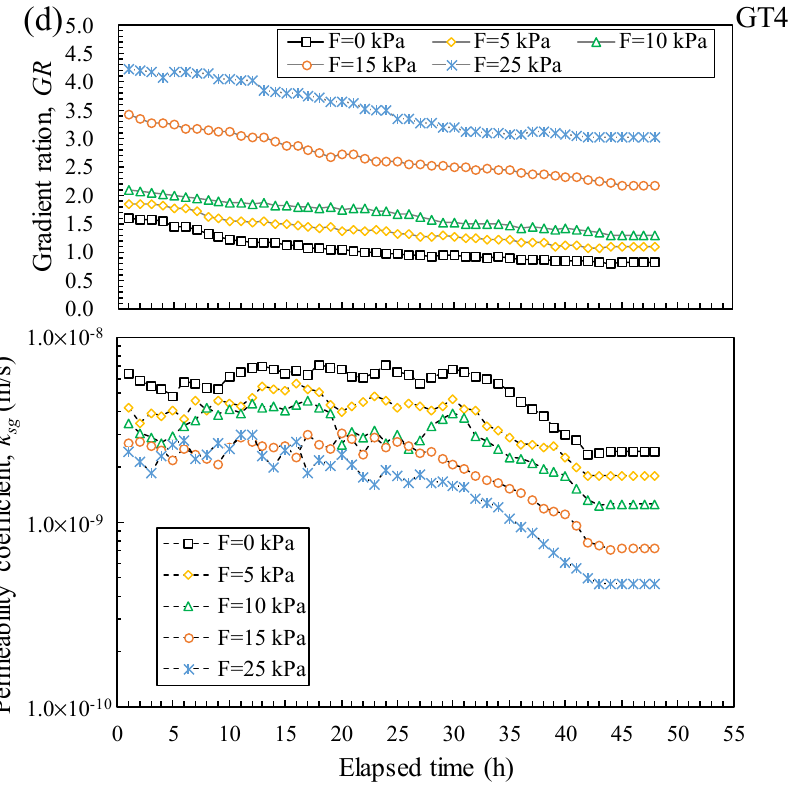
Figure 5. Filtration test results for silty clay with four geotextiles: ( a ) C-GT1 combination; ( b ) C-GT2 combination; ( c ) C-GT3 combination; ( d ) C-GT4 combination. Table 7. Summary of the gradient ratio test results at 48 h performed on the silty clay–geotextile combination.